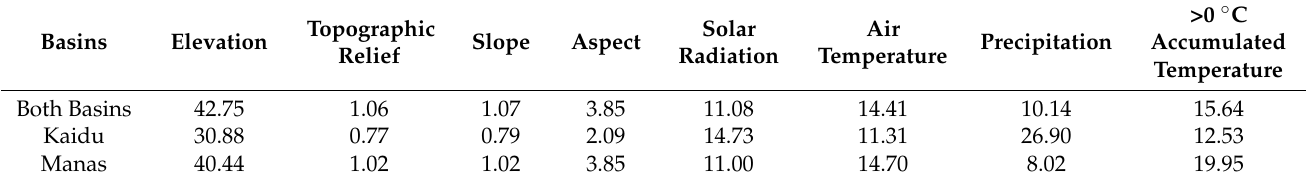
Table 2. Contribution rate of mass balance factor affecting glacier